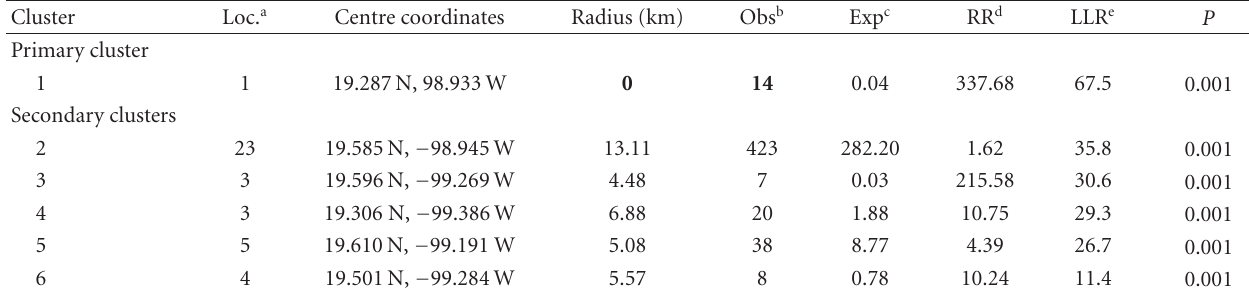
Table 1: TB clusters with a high RR identified in the State of Mexico using a space analysis and a search window maximum length of ≤ 50% and ≤ 25% population, adjusted for age-gender-margination.